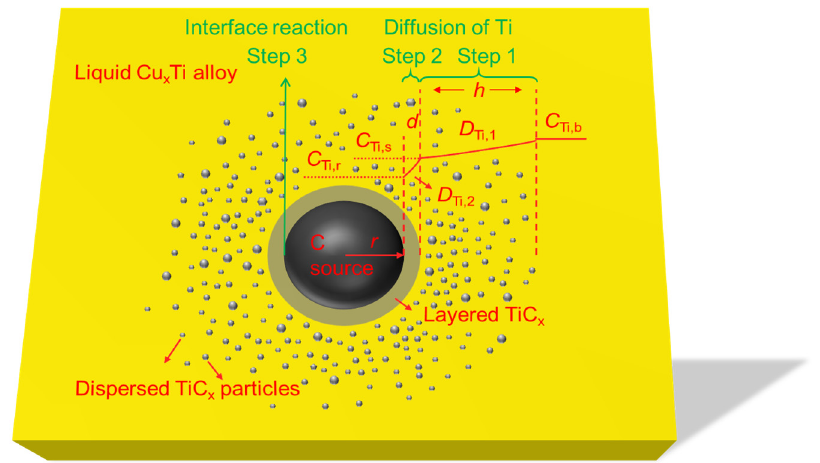
Figure 1. The schematic diagram of the reaction mechanism of spherical solid C source particles in Cu-Ti melt.